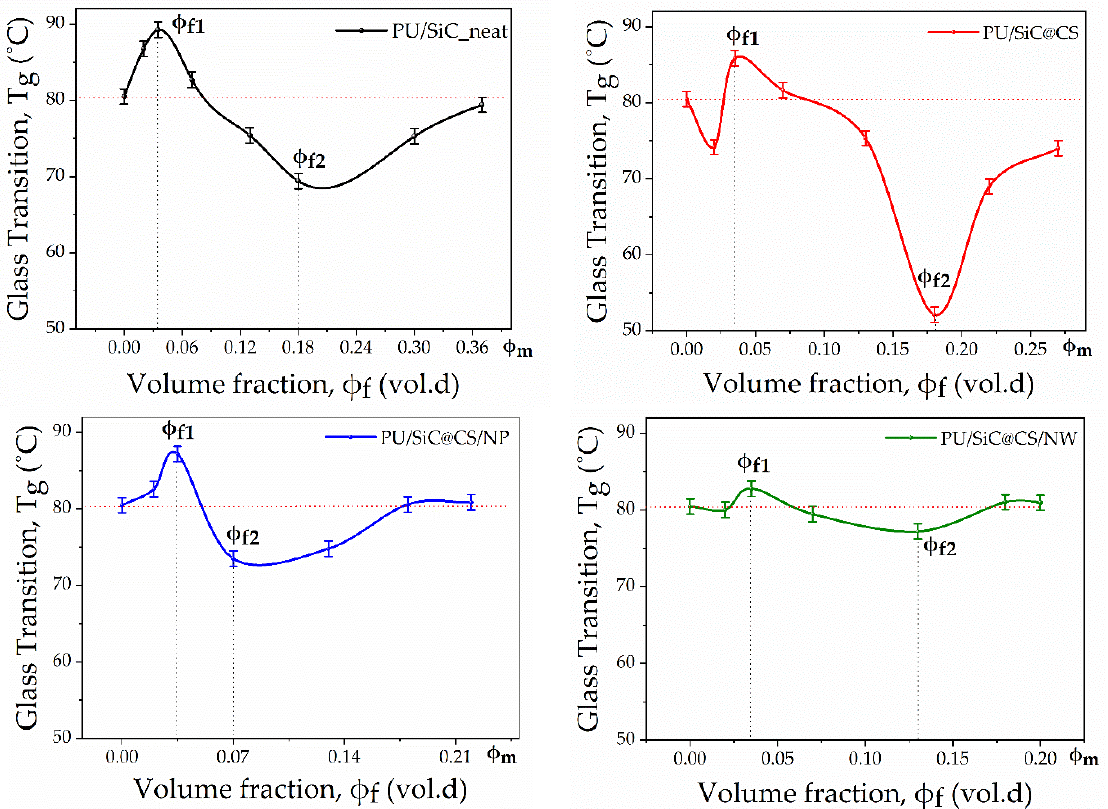
Figure 3. The glass transition temperature T g dependence on the concentration and type of morphology of the filler particles’ surface.